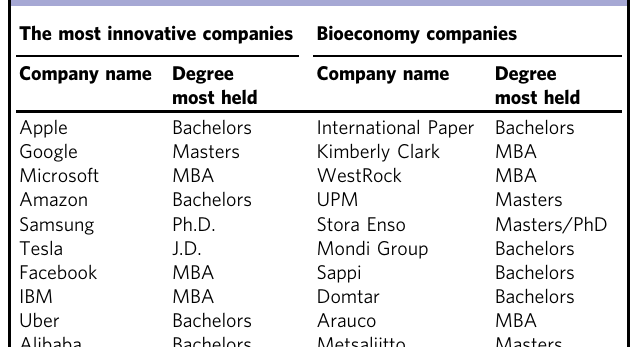
Table 2 Education degree held most using the mode